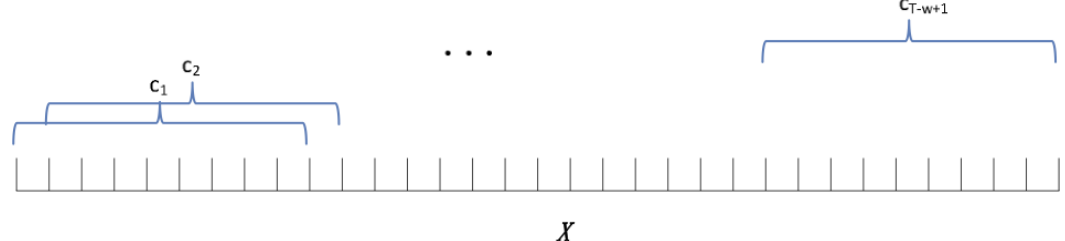
Figure 2. Data sequences X with length T , the subsequence of length w = 120 and the subsequences extracted by a sliding window c . Note that the sliding windows